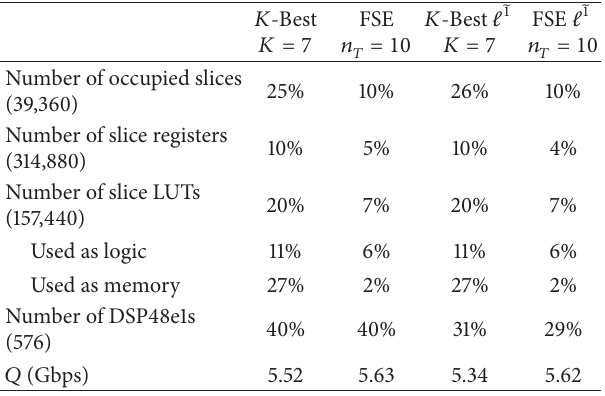
Table 1: Hardware resource occupation and throughput of the tree- search architectures under